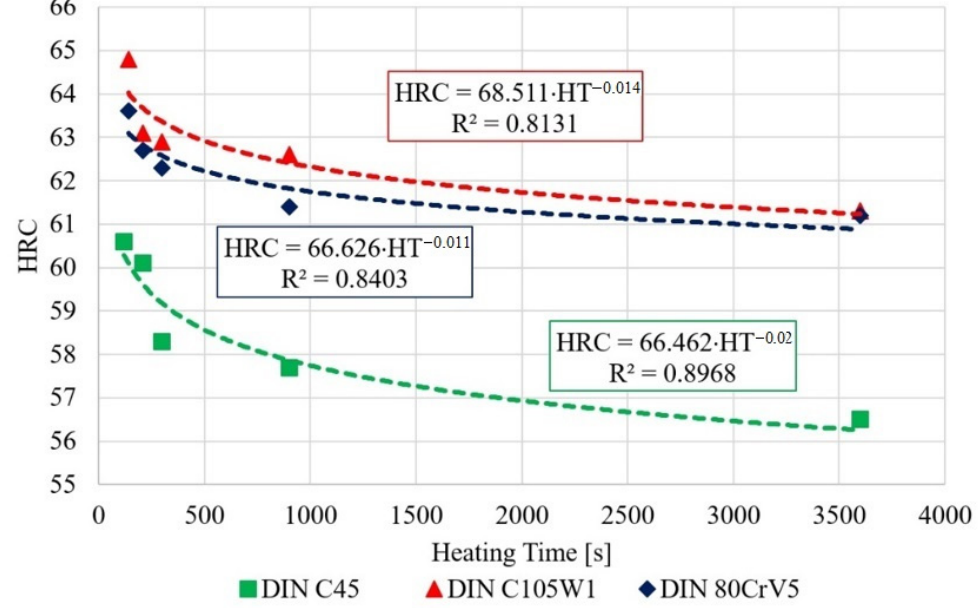
Figure 7. Decrease in the hardness depending on the heating time.